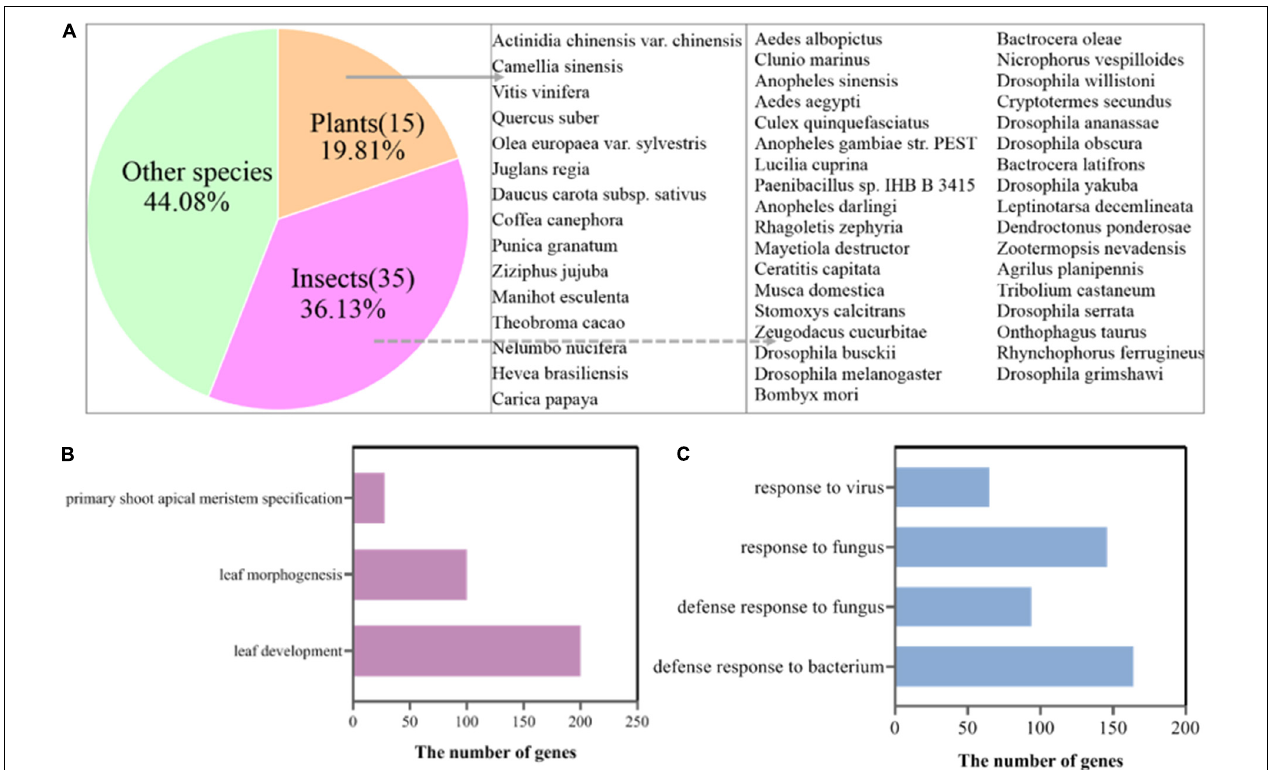
FIGURE 3 | (A) Alignment of unmapped sequences of SB tissue to other species sequences. (B) GO terms of the genes related to shoot development expressed in the SB tissue. (C) GO terms of the pathogen-related genes expressed in the SB